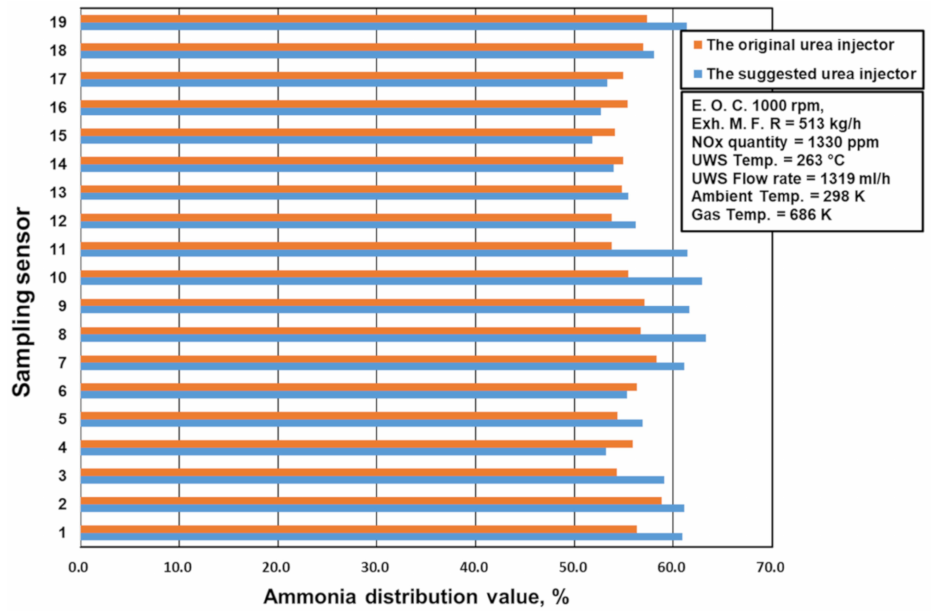
Figure 8. Sampled ammonia values by the 19 sensors in the catalyst inlet.